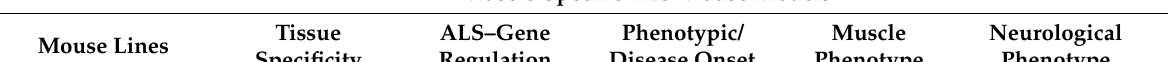
Table 2. Cont. Muscle-Specific ALS Mouse